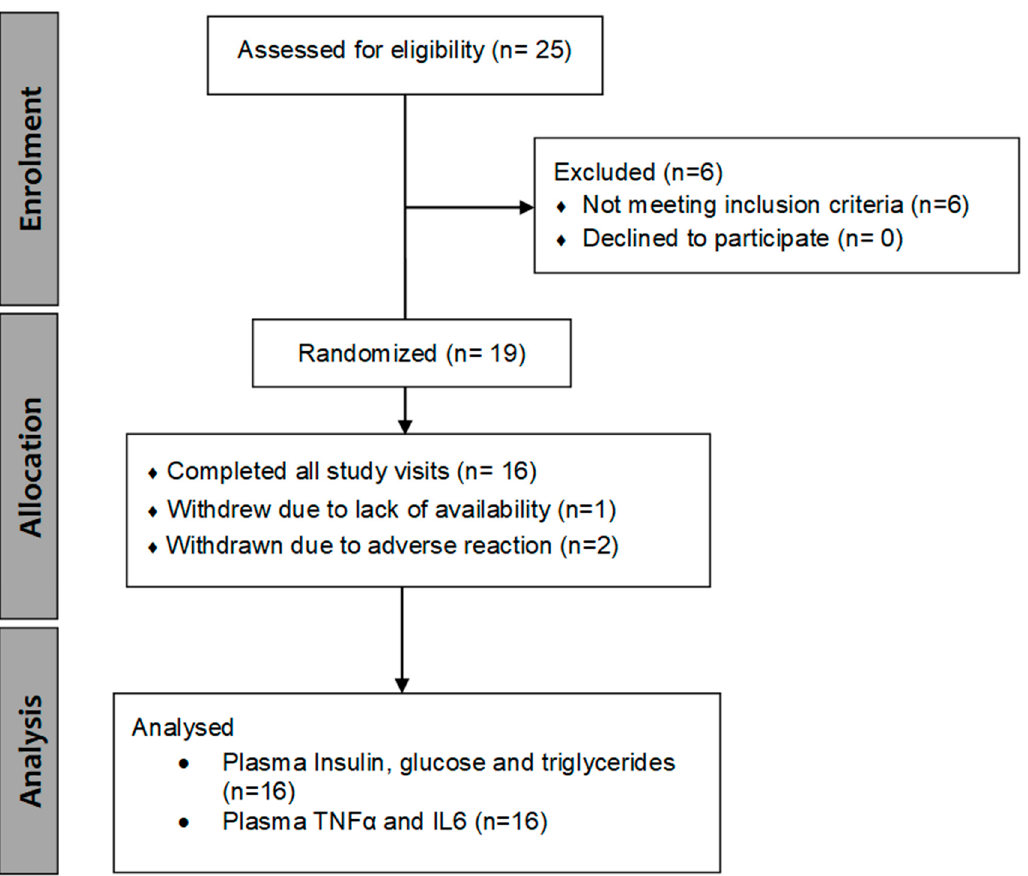
Figure 1. CONSORT flow diagram.